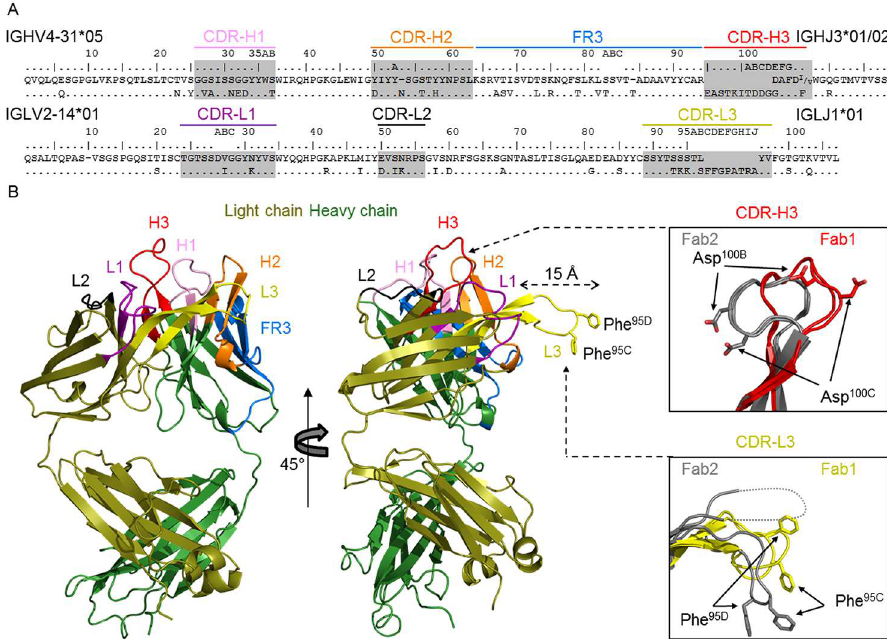
Fig 3. Crystal structure of CAP248-2Brevealsan unusually long, protruding CDR-L3, with a hydrophobic tip. (A) Sequencealignment of the CAP248-2B heavy and light chain with their predicted V- and J-geneprecursors. The CDRs are shaded, labelled, and colored. The heavy chain FR3 is similarly indicatedin blue. (B) Crystal structure of the CAP248-2BFab. The light and heavy chains are coloredolive and forest green respectively,whileCDR loops and FR-H3 are coloredaccordingto A. Two views are shown arounda ~45˚ axis to highlightthe long CDR-L3(yellow). Insets show the conformational differencesbetween the CDR-H3 and CDR-L3 loops betweenFab structure 1 (shown here) and Fab structure 2 (shown in S1 Fig). Two Fabs were present in both asymmetric units, so four loops are shown per inset, two for Fab1 CDR-H3 (red) or L3 (yellow), and two for Fab2 CDR-H3 and L3 (both grey). Asp 100B and Asp 100C in the heavy chain and Phe 95C and Phe 95D in the light chain are shown with stick representations to highlightthe conformational divergence betweenthe two structures. Due to crystal packingall downstreamanalyseswere based on the 3.1 Å Fab1